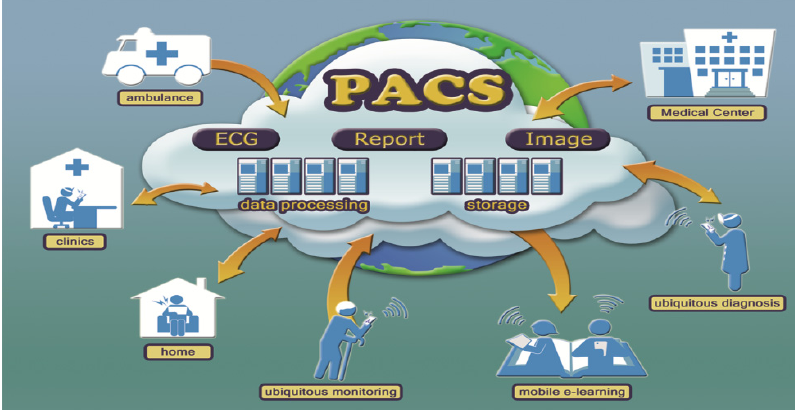
Figure 5. A global ECG and image cloud service for tele-consultation, research, and